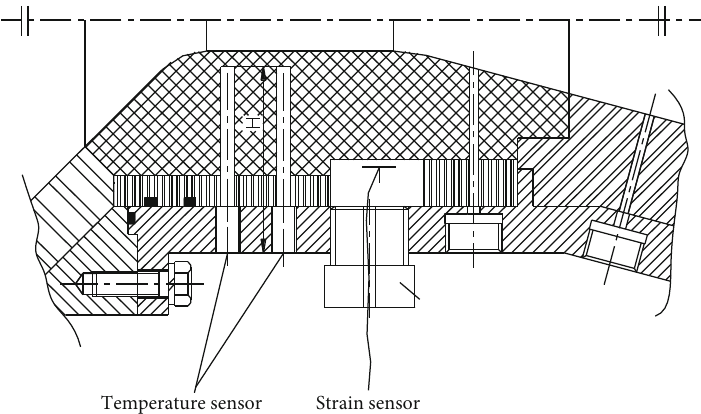
(d) The hoop strain contour considering the Jones-Nelson constitutive model Figure 7: Strain contours at 5 seconds.